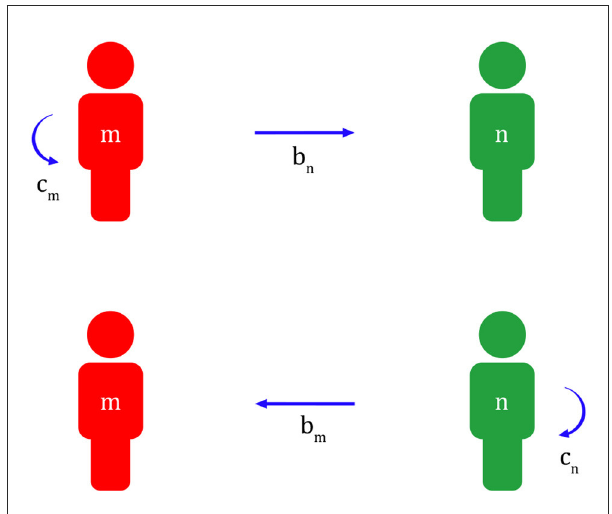
FIGURE1 Reciprocal altruism between a migraineur and a non-migraineur (m, migraineur; n, non-migraineur; c m , cost of migraineur; b m , benefit of migraineur; c n , cost of non-migraineur; b n , benefit of non-migraineur; b m - c m > 0, b n - c n > 0).